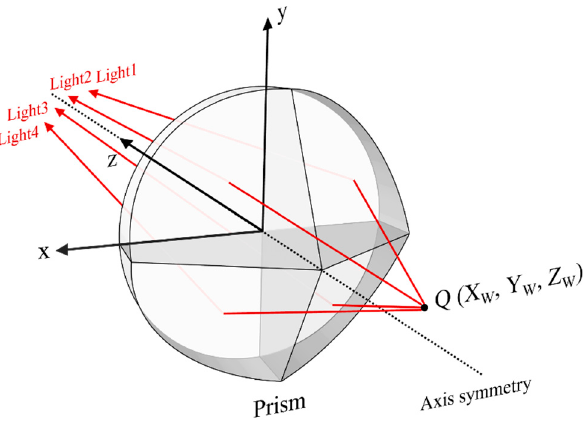
Figure 1. Basic schematic diagram of a pyramidal prism imaging path.